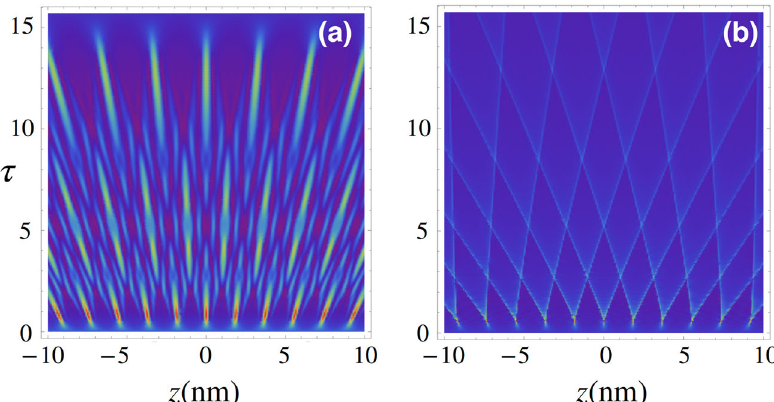
Fig. 5 Talbot carpet arising from pure phase-grating without any source of decoherence for a point-like particle. This picture shows the comparison between ( a ) the interference pattern predicted by quantum mechanics, P ( z ) in Eq. (5), and ( b ) the shadow pattern that is formed by classical particles following ballistic trajectories (on the right) for different values of τ = t 2 / t T , where t 1 , t 2 are the free evolution times before and after the laser grating while t T is the Talbot time of the interferometer. It is then apparent that, in order to can claim the observation of a quantum superposition, we need to be able to distinguish between these